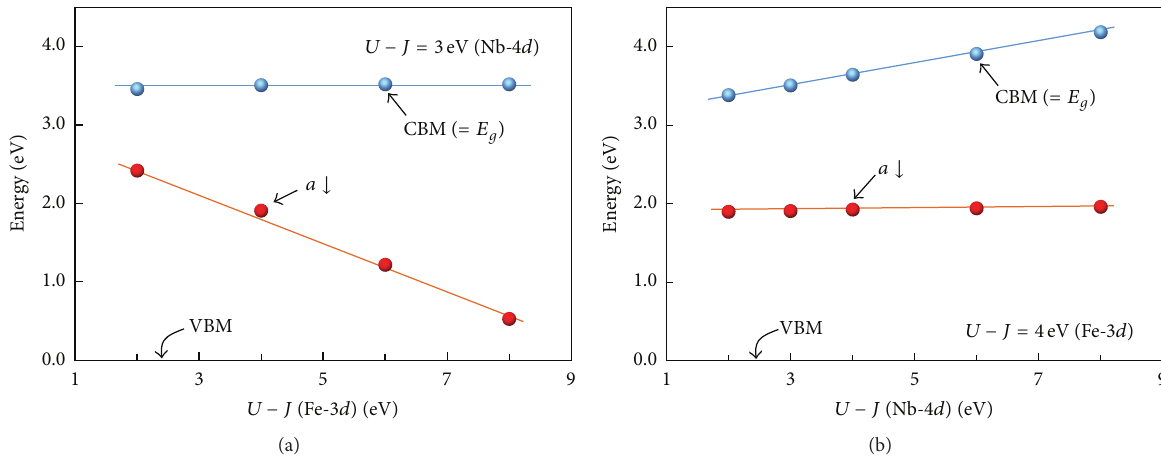
Figure 7: Energy levels at the Γ point of the a ↓ gap sate of Fe-3 d and the CBM with respect to the VBM in the Fe 2+ Li -LiNbO 3 cell calculated by the LSDA + U approach with various 𝑈−𝐽 terms: (a) the 𝑈−𝐽 value of Nb-4 d is fixed to be 3 eV and that of Fe-3 d varies and (b) the 𝑈−𝐽 value of Fe-3 d is fixed to be 4eV and that of Nb-4 d varies. The value of band gap ( 𝐸 𝑔 ) accords with the energy difference between the CBM and the VBM.